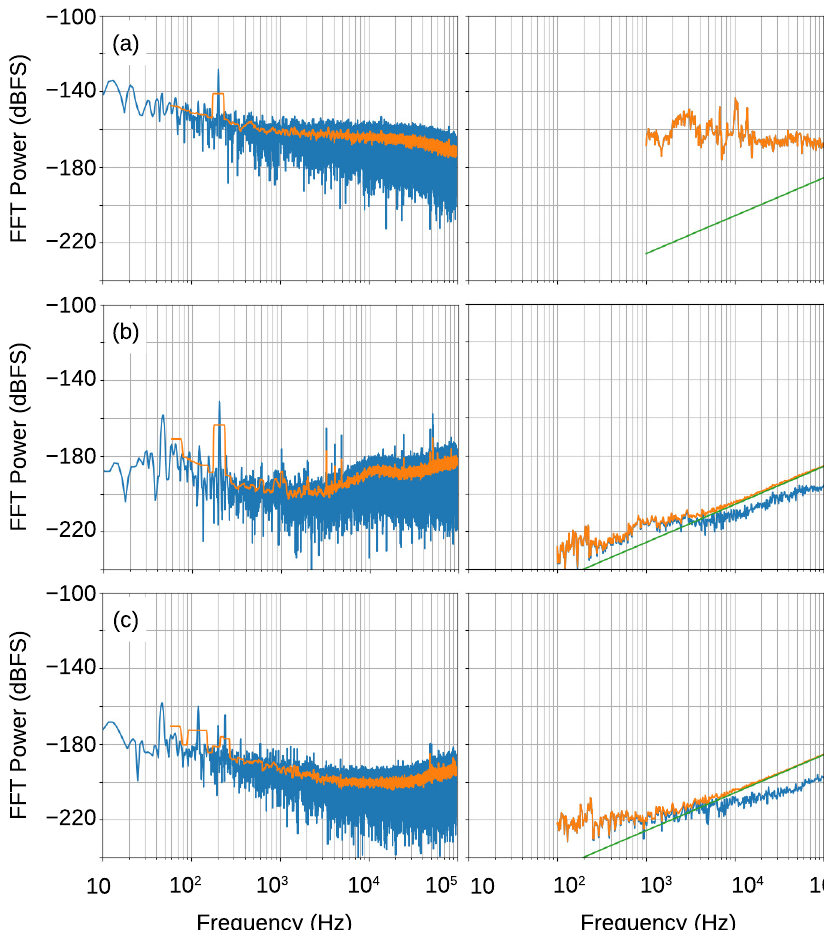
Figure 17. Measured and calculated in-band noise spectra. Left figures: measured results from the FDSM analyzer, Right figures: calculated noise spectra. In the left figures, the moving averages are plotted by orange lines. In the right figures, the blue lines show the noise due to the phase noise, the green lines show the quantization noise, and the orange lines show the sum of two noises. ( a ) Reflection oscillator with down-conversion, ( b ) transmission oscillator without down-conversion, ( c ) transmission oscillator with down-conversion. In the right figure in ( a ), the total noise is almost equal to the noise due to the phase noise. Consequently, the blue line is completely overlapped by the orange